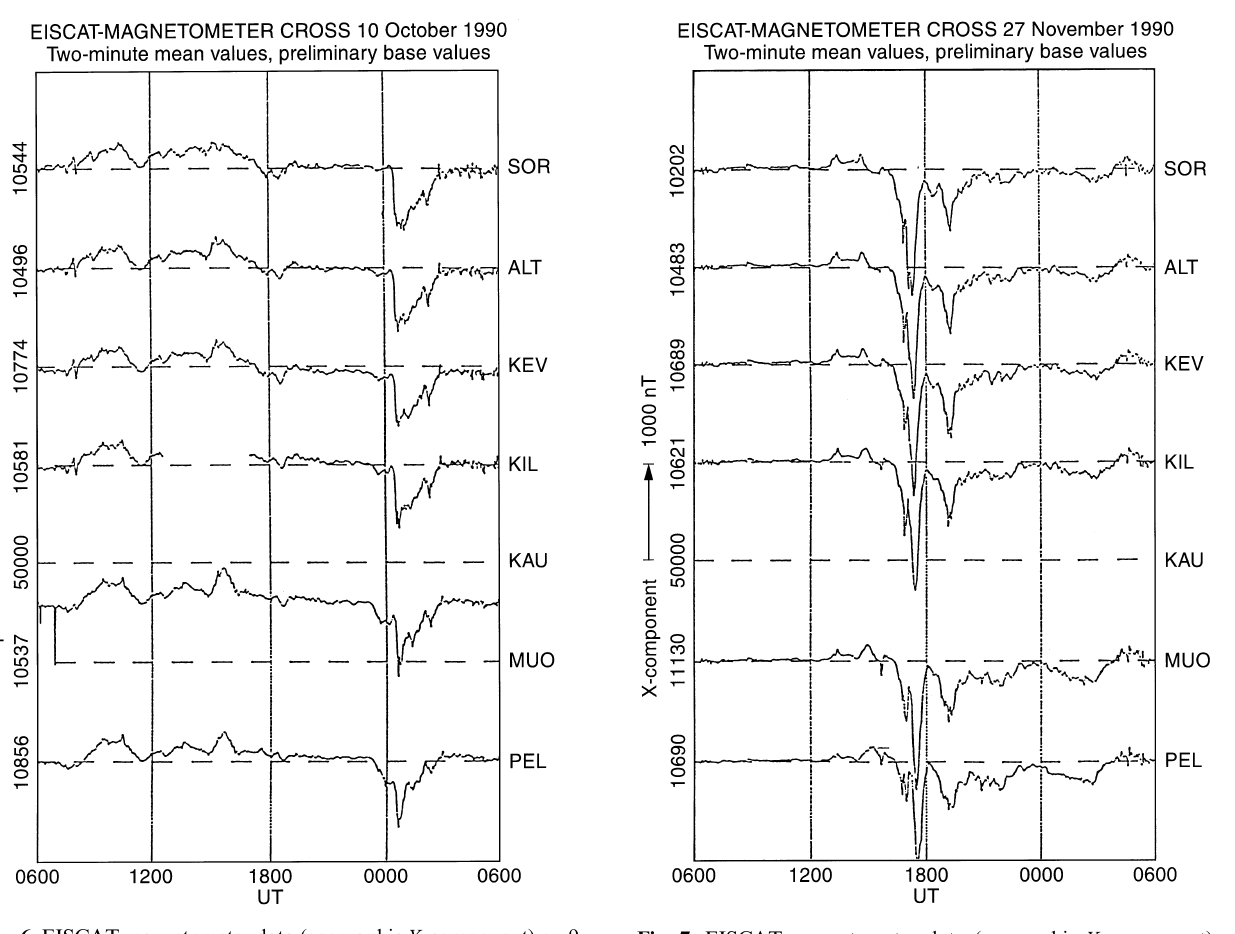
Fig. 7. EISCAT magnetometer data (geographic X -component) on 27–28